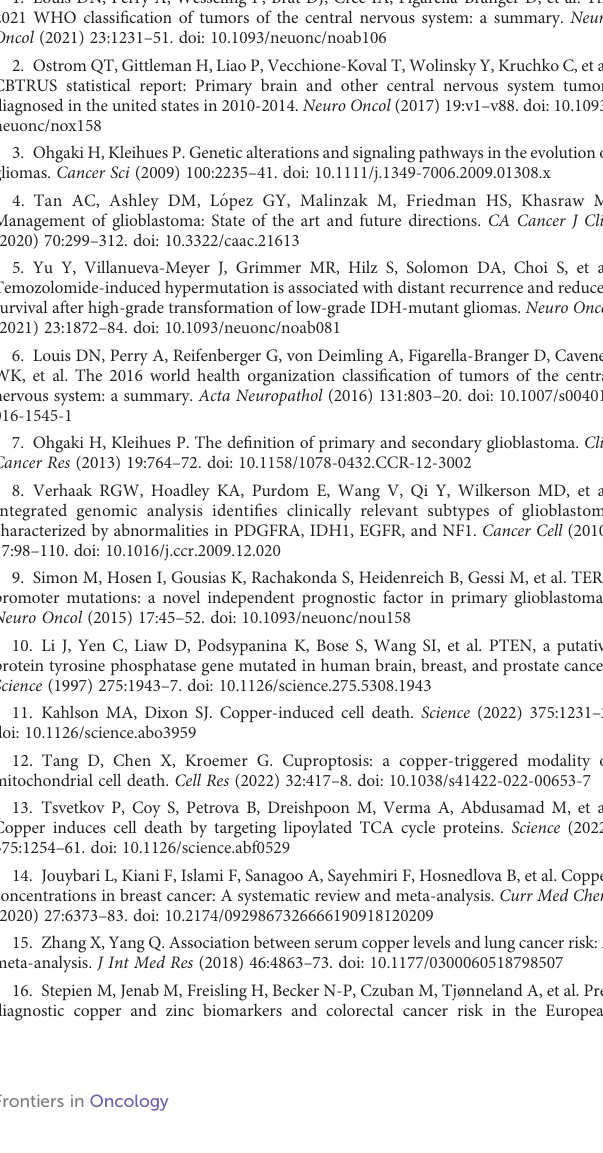
SUPPLEMENTARY FIGURE 1 PPI network between cuproptosis-related genes and LGG lncRNAs. SUPPLEMENTARY FIGURE 2 Kaplan-Meier curves of OS in 12 DEGs. SUPPLEMENTARY TABLE 1 GSEA analysis of DEGs based on HALLMARK genes